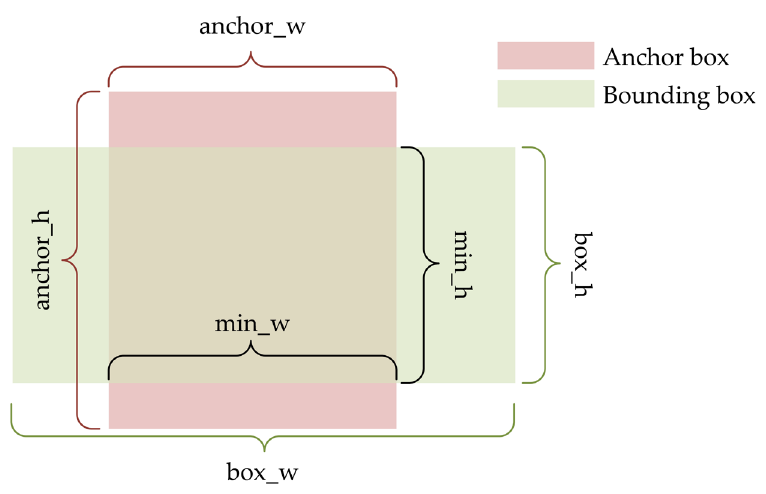
Figure 3. Illustration of the IoU calculation.